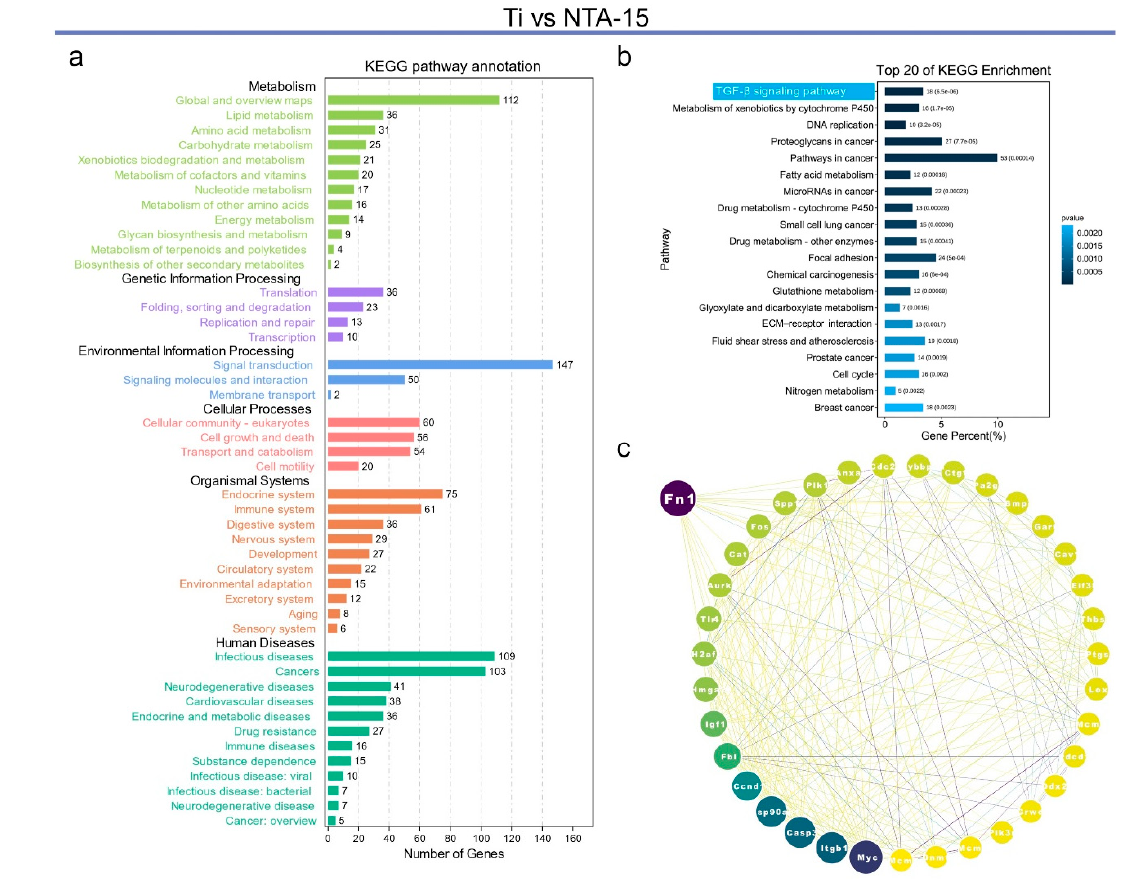
Figure 5. Analysis of differential genes within Ti vs. NTA-15. ( a , b ) KEGG pathway annotation and enrichment analysis of Ti vs. NTA-15, respectively. ( c ) Protein interaction analysis of the differentially expressed genes.